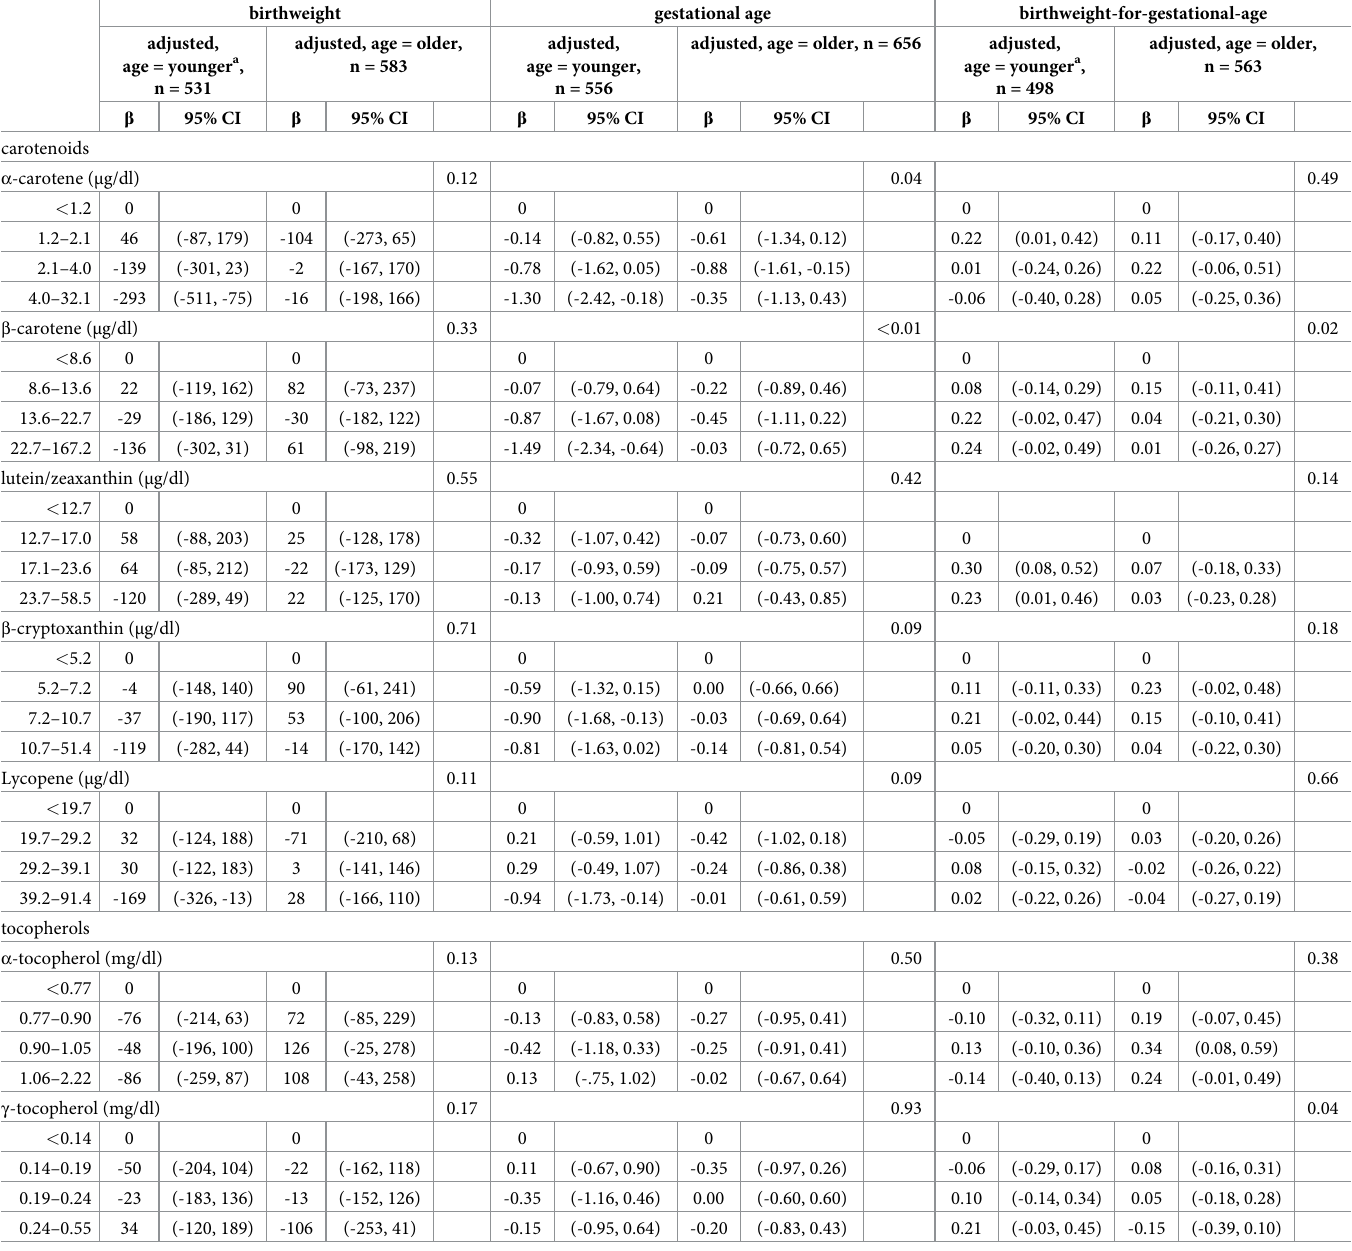
Table 5. Relationship between serum antioxidant status, as quartiles, and subsequent birth outcome, stratified by